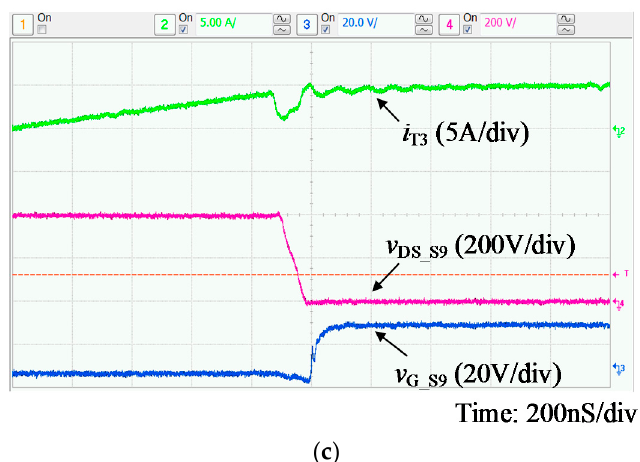
Figure 15 . Experimental results of MR-TP-BDC and SR-TBC under 1000 W. ( a ) MR-TBC of 110 kHz; ( b ) SR-TBC of 110 kHz; ( c ) SR-TBC of 125 kHz.